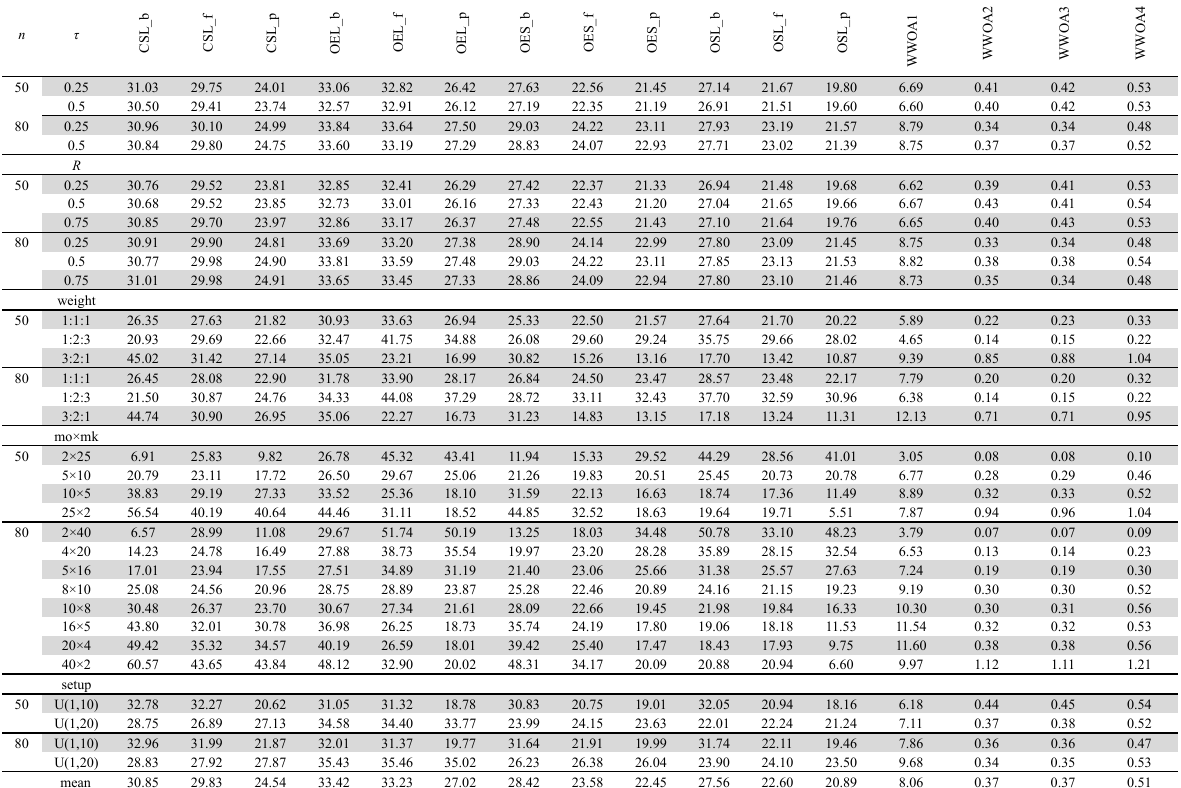
RPD of 12 heuristics and 4 WWO algorithms for large n =50,